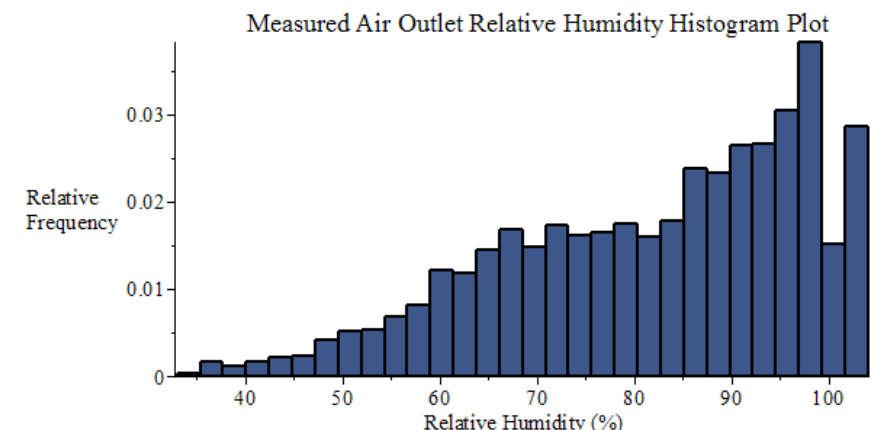
Figure A2. Histogram plot of the measured air outlet relative humidity, within the 7688 data sets collected by SRNL from F-Area cooling towers (unsaturated conditions).